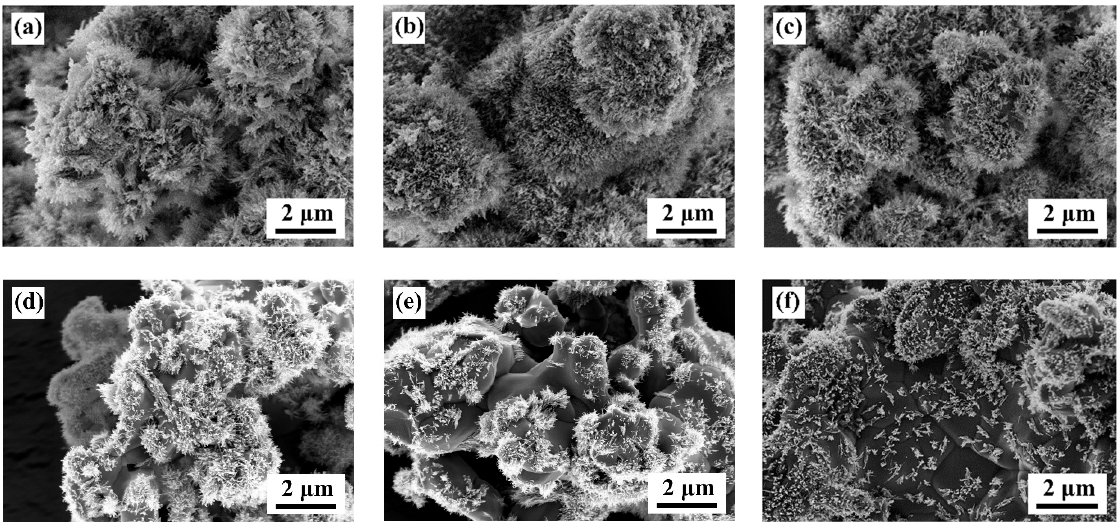
Figure 3. FE - SEM images of the [Sr 0.99 Eu 0.01 ] 3 MgSi 2 O 8 phosphors sintered for different durations: ( a ) 1, ( b ) 2, ( c ) 3, ( d ) 4, ( e ) 5, and ( f ) 6 h.